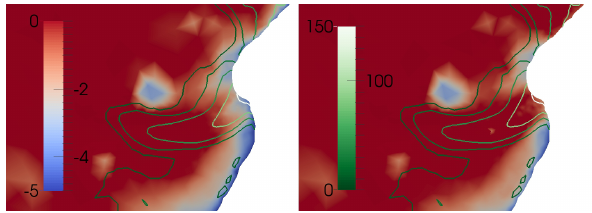
Fig. 9. Basal temperatures (in centigrade relative to the pressure melting point) in the Basin 3 outlet glacier region from the transient simulation T_T95 after 10 years of integration (left) and 50 years (right). 1995 velocity contours (in ma − 1 ) are overlain to indicate regions of fast flow.